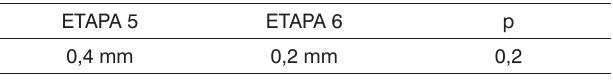
Tabela 4. Comparação das médias entre as etapas 1 (sem o sis- tema; tesoura parada) e 5 (com o sistema; tesoura no centro; fio afrouxado em 3 mm).